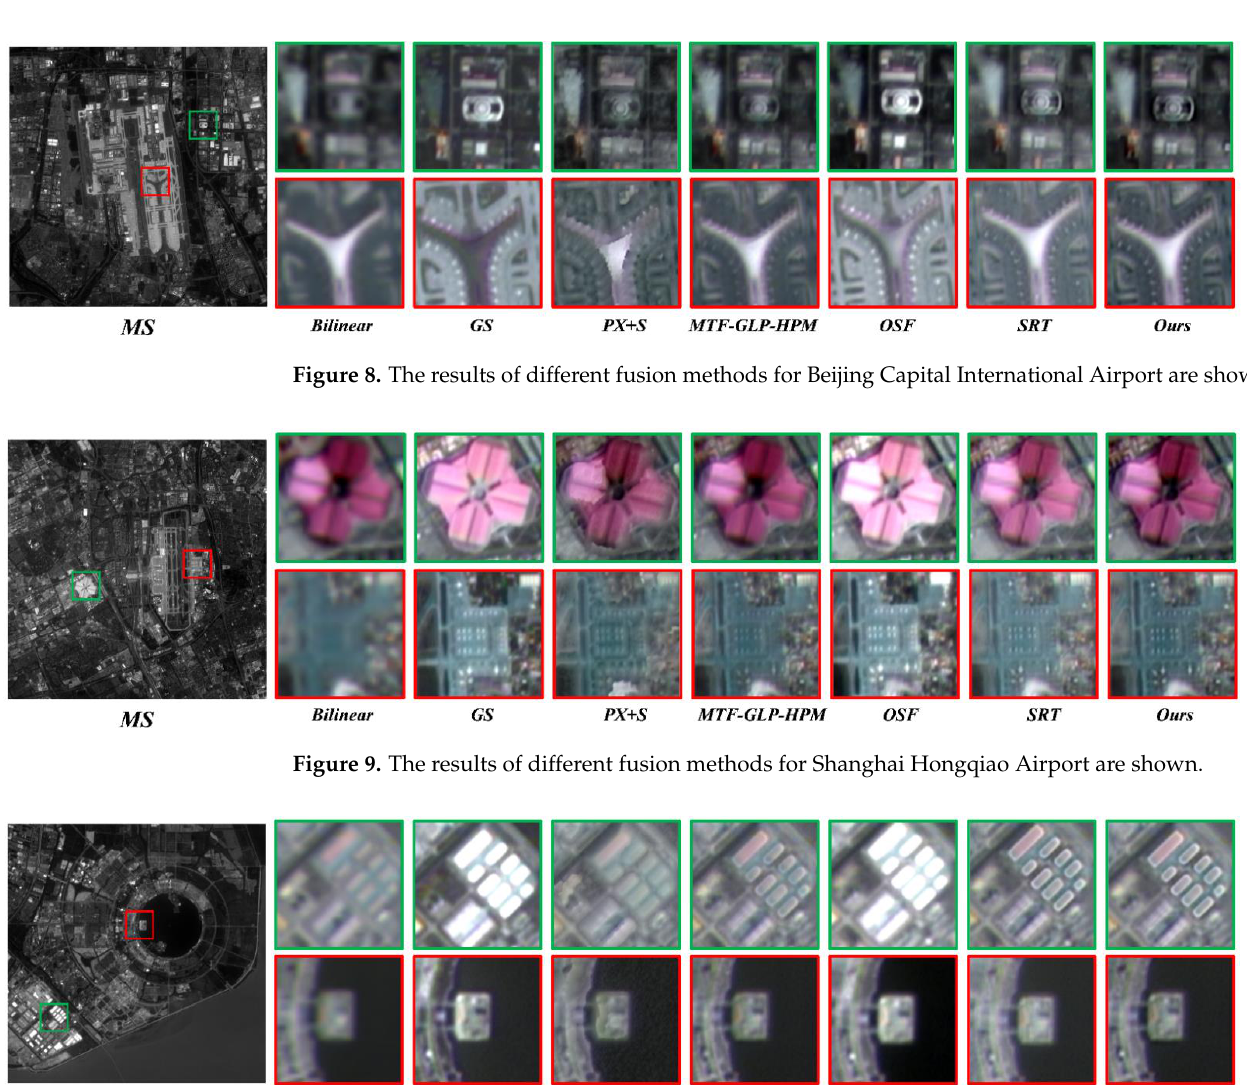
Figure 7. The results of different fusion methods for the Forbidden City area in Beijing are shown.